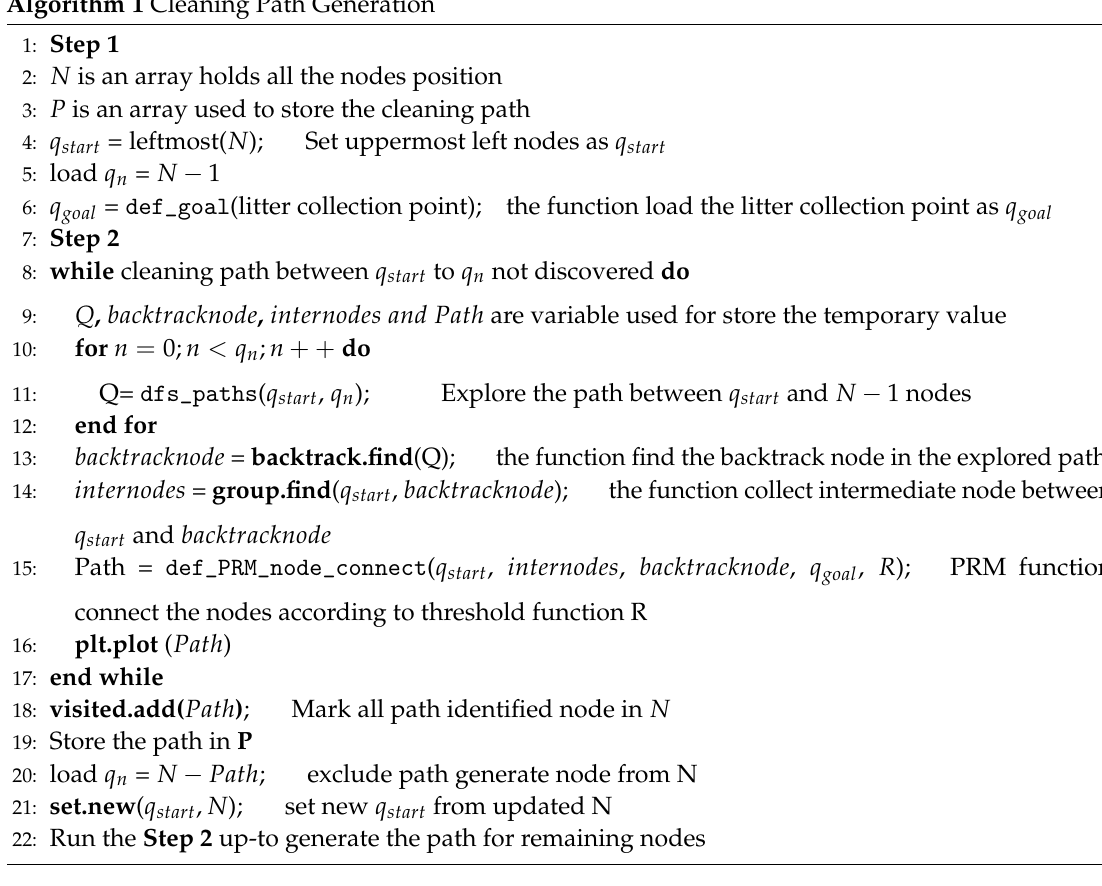
Algorithm 1 Cleaning Path